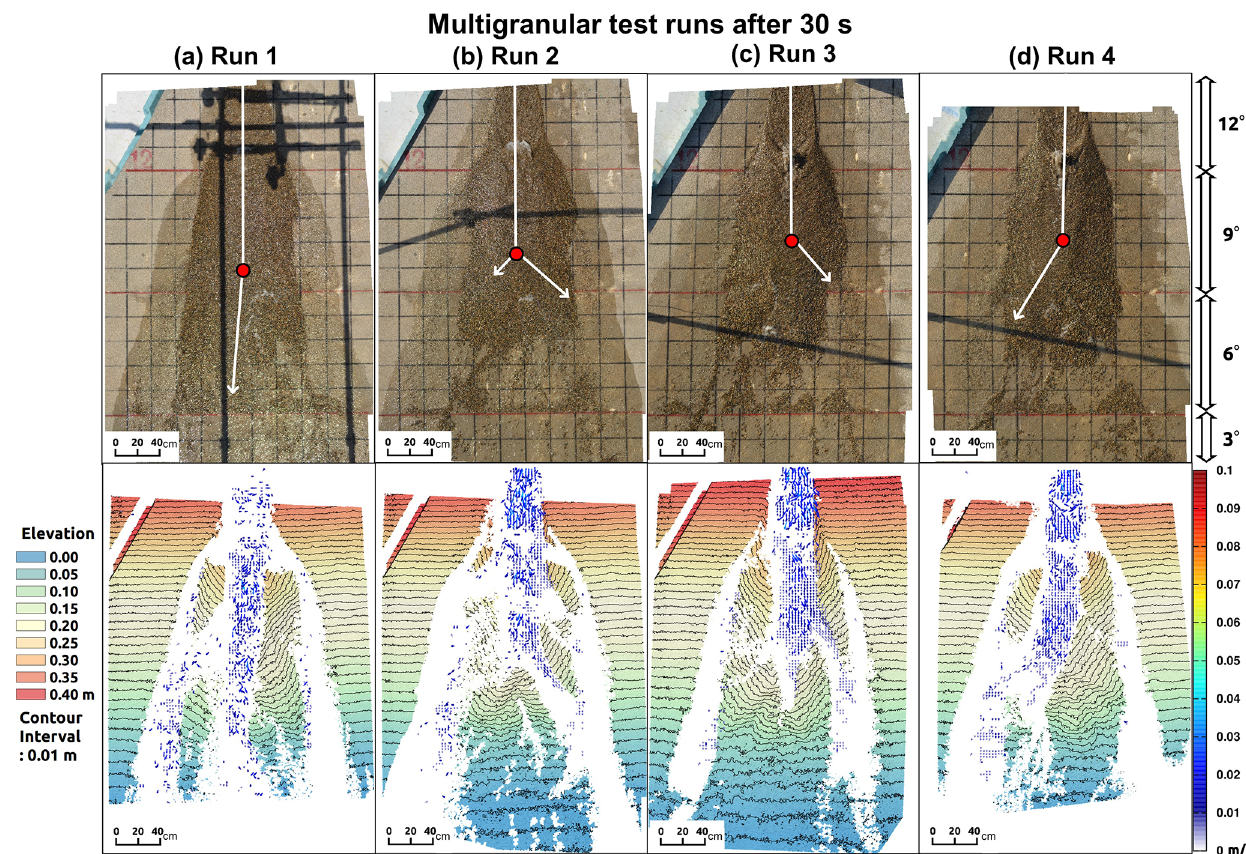
Figure 11. Fan morphology 30s after the start of runout of the multigranular flows. The upper and lower panels show orthophotos and digital elevation models (DEMs) with flow vectors, respectively. Respective sets of the upper orthophoto and lower DEM represent corresponding results of each experimental test run. The white arrows on the orthophotos indicate the assumed principal direction of flow descent. The red points in the orthophotos indicate the assumed occurrence point of the avulsion. The elevation of the DEMs is depicted assuming that the area with a 3 ◦ slope (i.e., the area furthest downstream from where the slope angle changed from a 6 to 3 ◦ slope) has elevation of